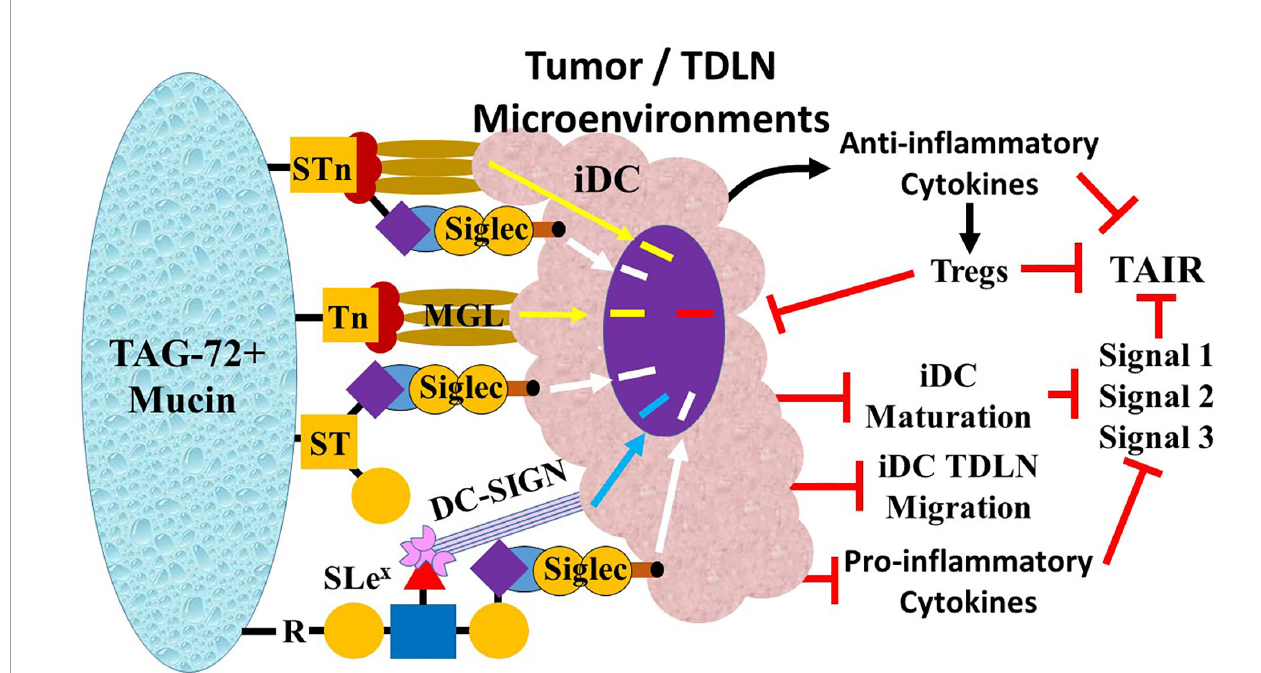
FIGURE 7 | Overview of tumor-associated immune response (TAIR) suppression by Tn, STn, and ST. TAG-72-related suppression of the TAIR begins with the ligands Tn, STn, ST, and SLe X on the TAG-72-positive mucin molecules binding to lectins on immature dendritic cells (iDCs). The sialic acid carbohydrate on ST, STn, and SLe x bind to Sialic Acid Recognizing Ig-like Lectins (Siglec), while the galactose on Tn and STN binds to Macrophage Galactose-Type Lectin (MGL), and the fucose of the Lewis antigens (Lex, SLe x , and Le y ) bind to Dendritic Cell-Speci fi c ICAM-3 Grabbing Non-Integrin (DC-SIGN). The binding generates variable inhibitory signal pathways (MGL, yellow arrow; Siglecs, white arrow; DC-SIGN, blue arrow) that suppresses ( ) iDC maturation. Inhibition of iDC maturation inhibits iDC migration to tumor draining lymph nodes (TDLNs). Function changes including inhibition of the major histocompatibility complex (MHC) molecule expression (Signal 1), expression of co-stimulatory molecules (Signal 2), and secretion of pro-in fl ammatory cytokines (e.g., IL-6 and IL-12) (Signal 3) suppress the TAIR. Concurrently, there is increased release of anti-in fl ammatory cytokines (e.g., IL-10 and TGF- b ) (black curved arrow) that further suppresses the T-helper 1 (Th1) TAIR and while activating (short black arrow) Th2, Th17, and regulatory T (Treg) cells. Treg activation suppresses the TAIR by further inhibiting iDC maturation (long black arrow) via cytotoxic T lymphocyte-associated protein 4 (CTLA-4) binding to CD80/86 co-stimulatory molecules and induces Th1 anergy by removing IL-2 from the environment. The result is suppression of the